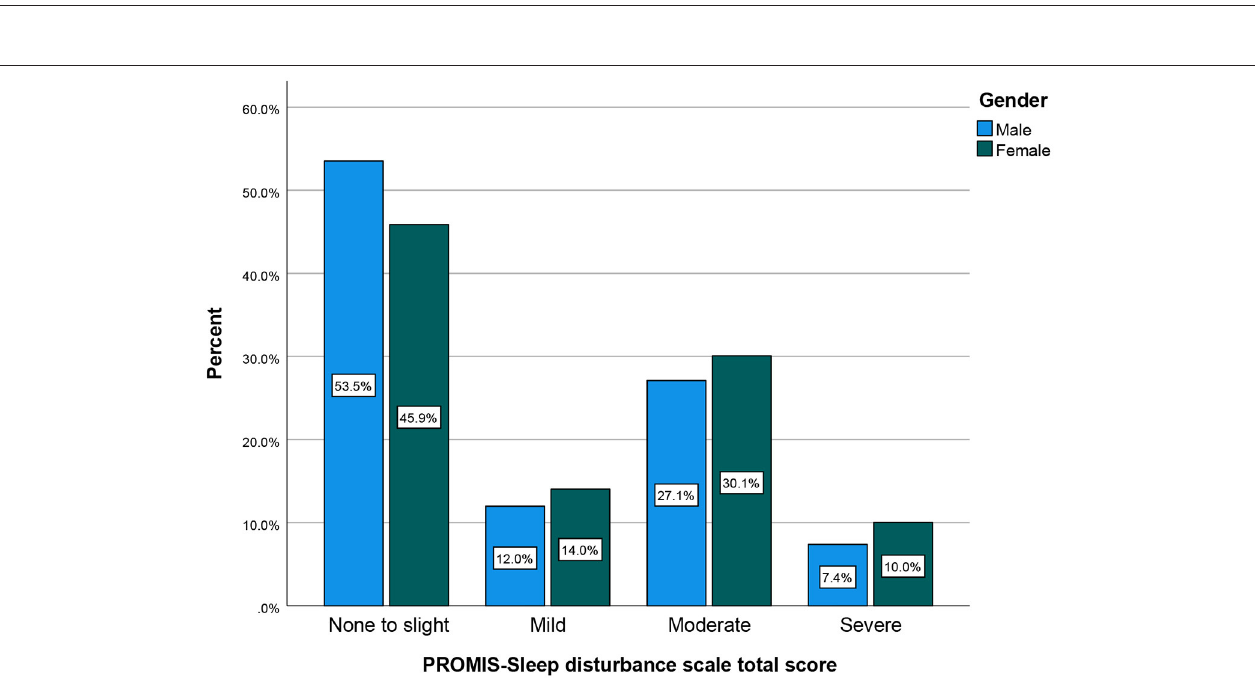
FIGURE 2 | Sleep disturbance total score by gender (cluster bar count).